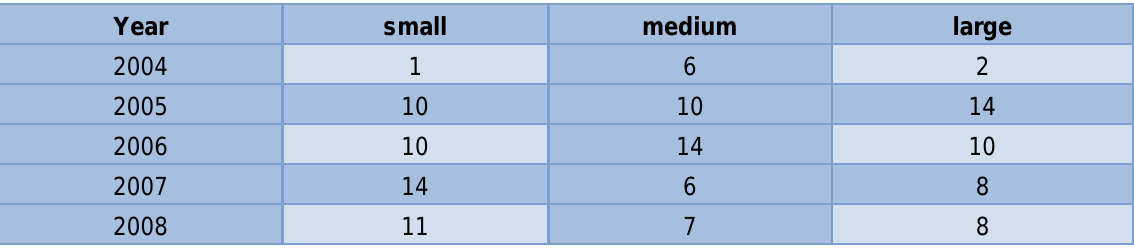
Table 5 Projects distribution based on size category in each year of award Selection of Forecasting